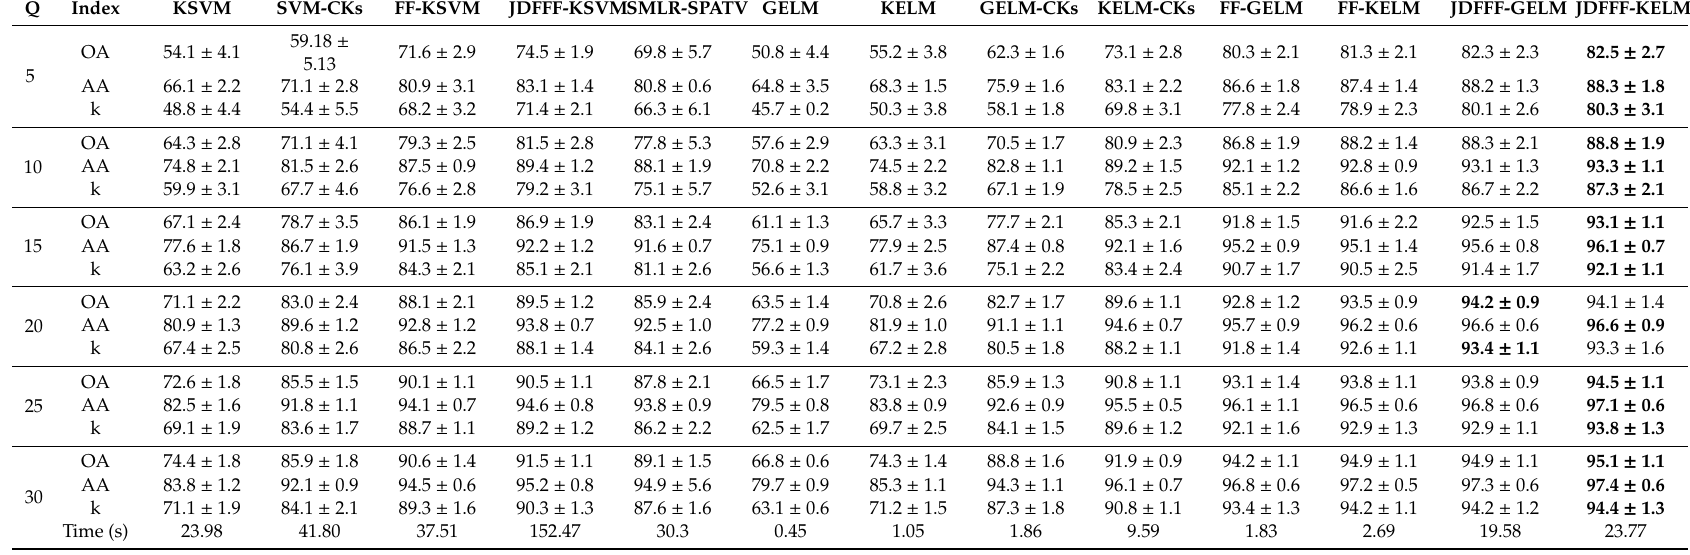
Table 4. Classification accuracy (%) with di ff erent numbers of labeled samples for the Indian Pines dataset (the best result of each row is marked in